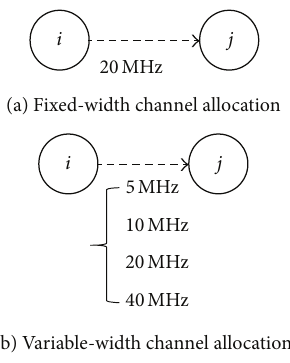
Figure 4: Illustration of the difference between fixed-width and variable-width channel allocation